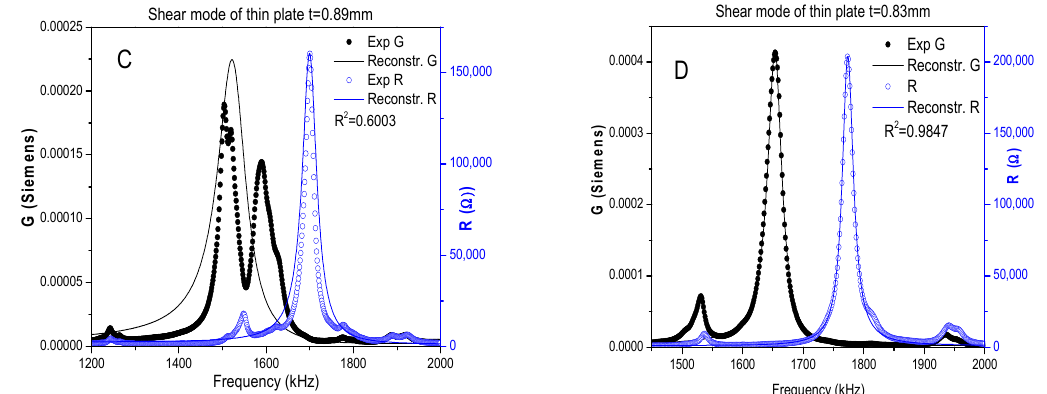
Figure 3. Experimental response at RT (symbols) plotted as R (blue) and G (black) peaks, together with the reconstructed spectra after parameter determination by iterative analysis (continuous lines), for: ( A ) planar and ( B ) thickness resonance modes of a thickness-poled, thin disk of BNBT6 ( t = 1.91 mm and D = 10.60 mm); and for a shear resonance of a thickness-poled, thin plate of BNBT6 (9.53 × 9.43 mm): ( C ) with t = 0.89, with strong coupling of modes and not fitted for parameters determination; and ( D ) with t = 0.83 mm, virtually uncoupled. The regression factor of the reconstructed to the experimental spectra (R 2 ) is shown for each analyzed resonance.